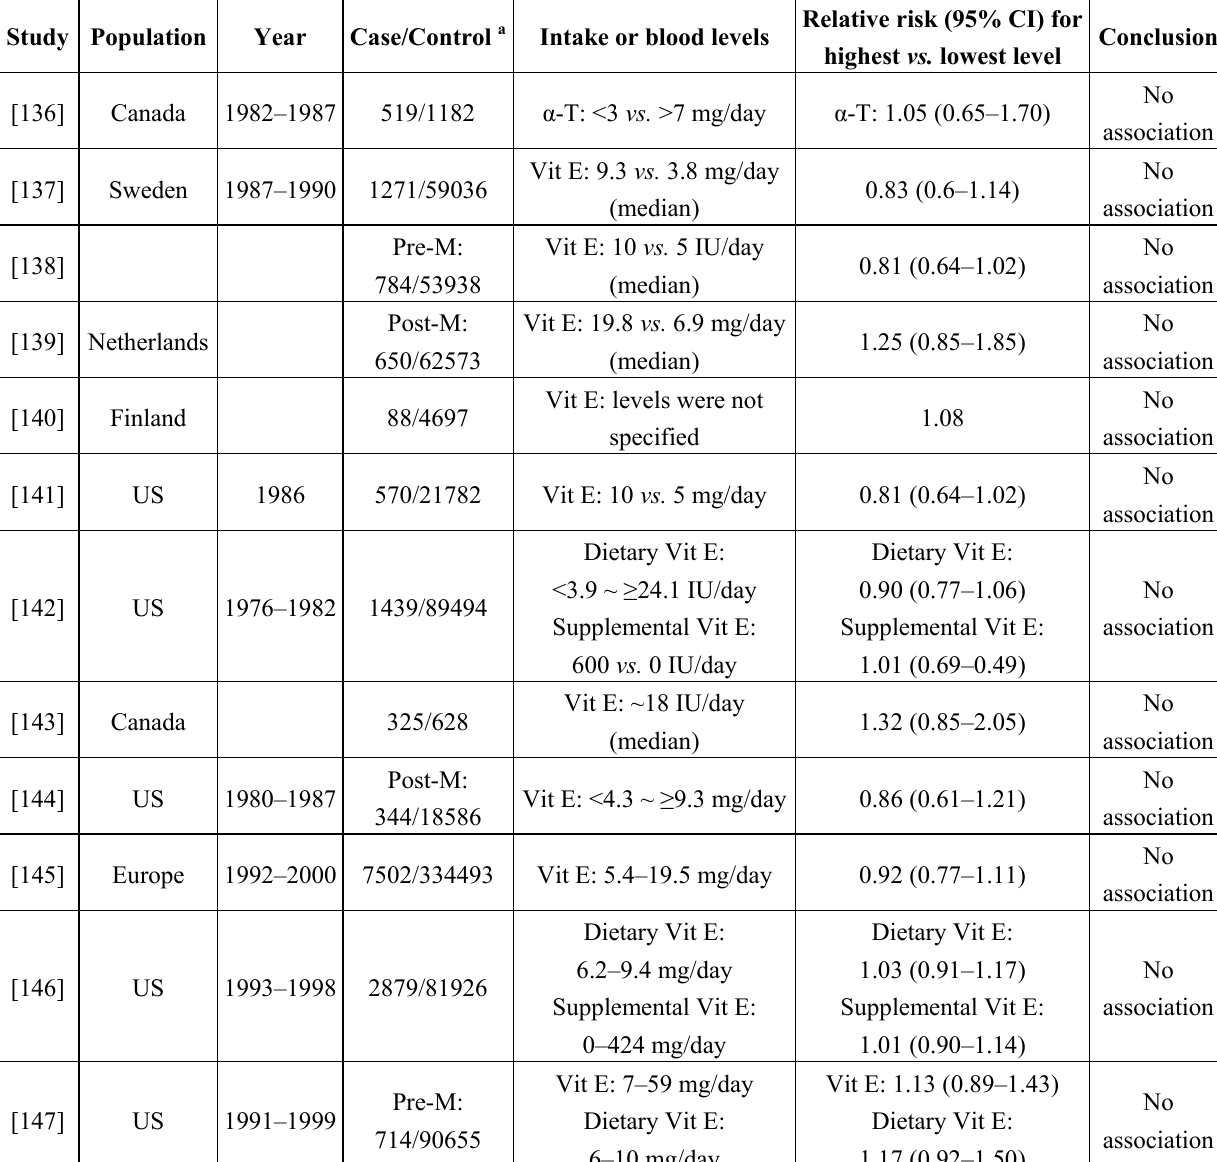
Table 6. Cohort studies of vitamin E and breast cancer